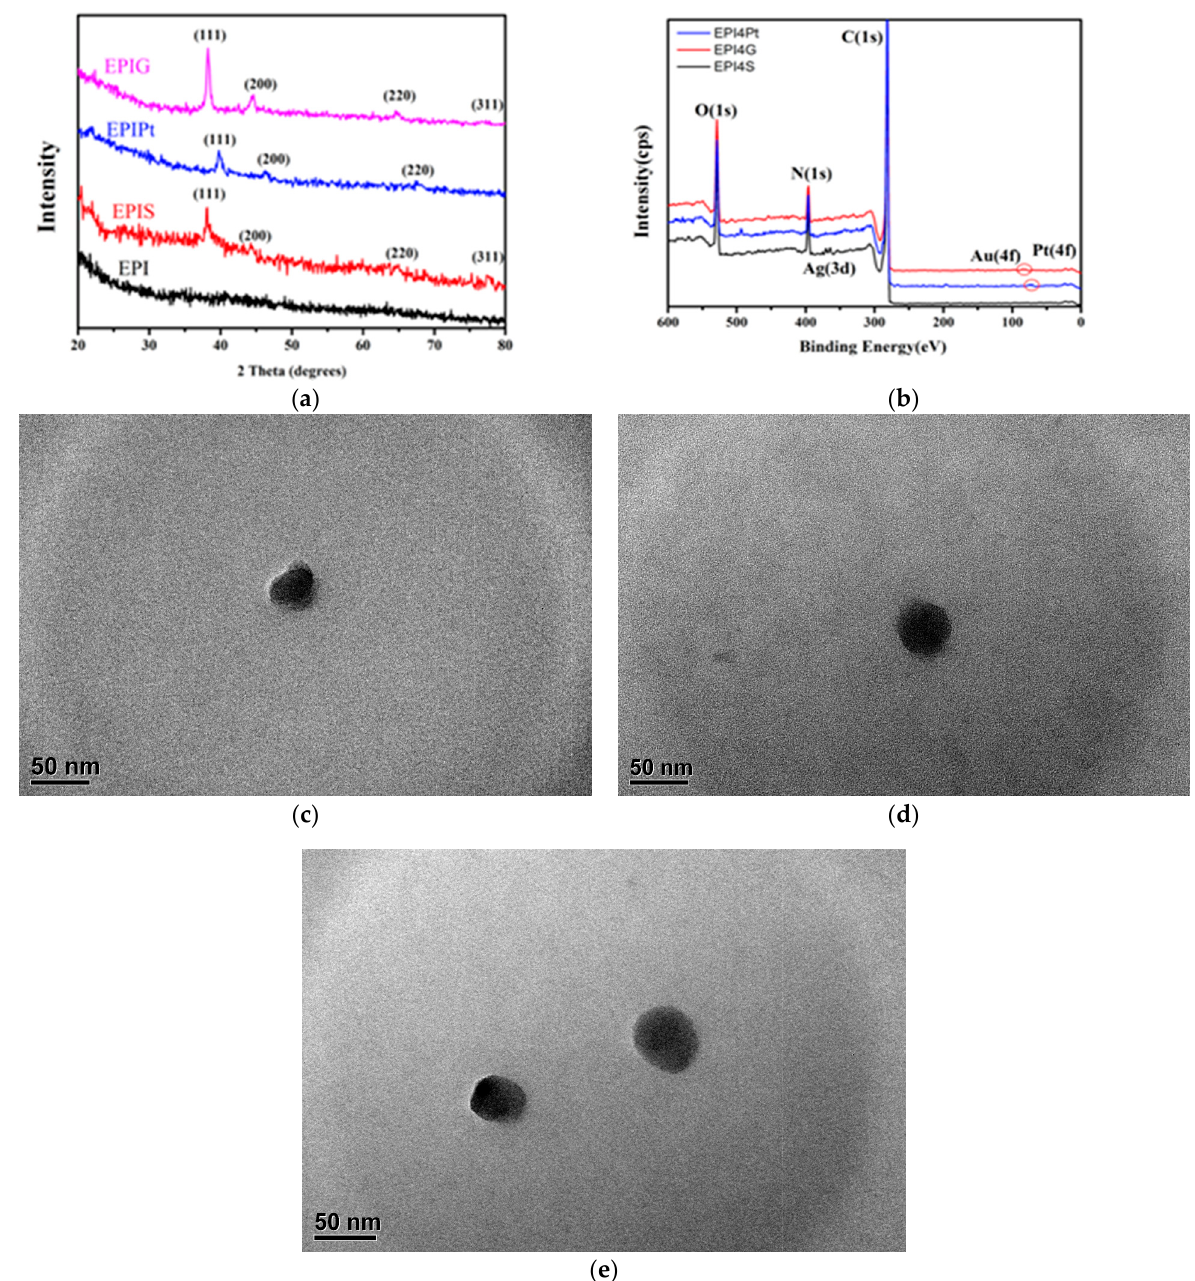
Figure 4. Characterization of EPIS, EPIP, EPIG as determined by XRD ( a ), XPS ( b ), TEM images EPIS ( c ), EPIP ( d ), and EPIG ( e ).